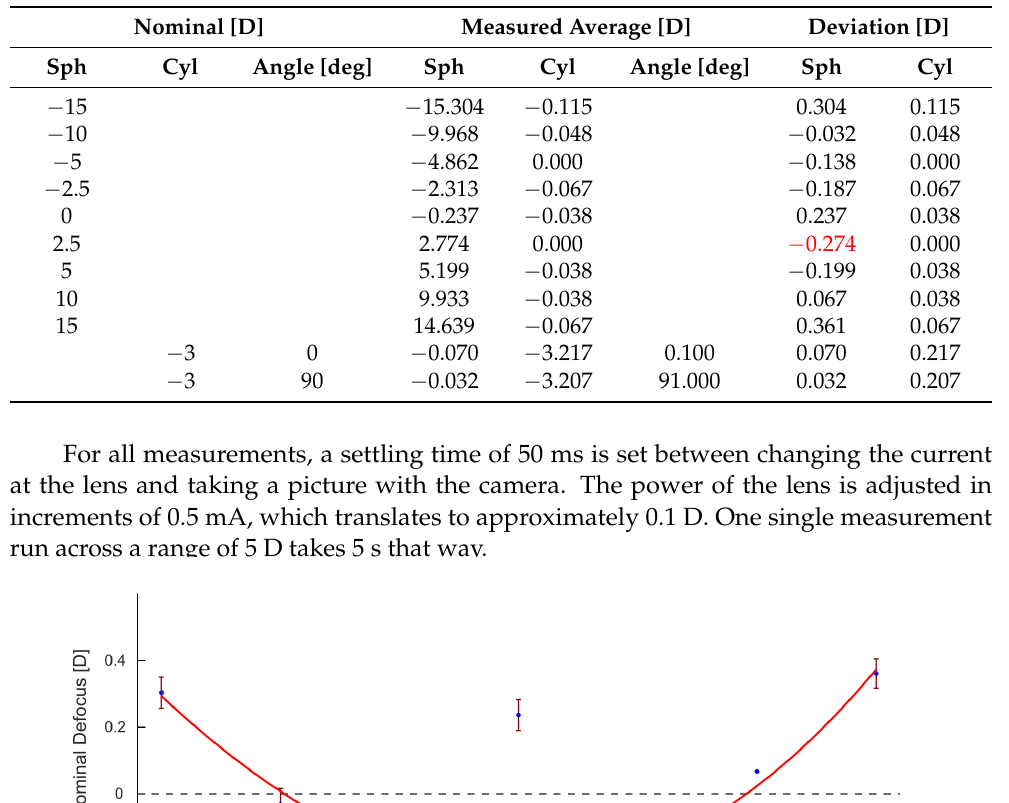
Table 1. Measurement results with test eyes.